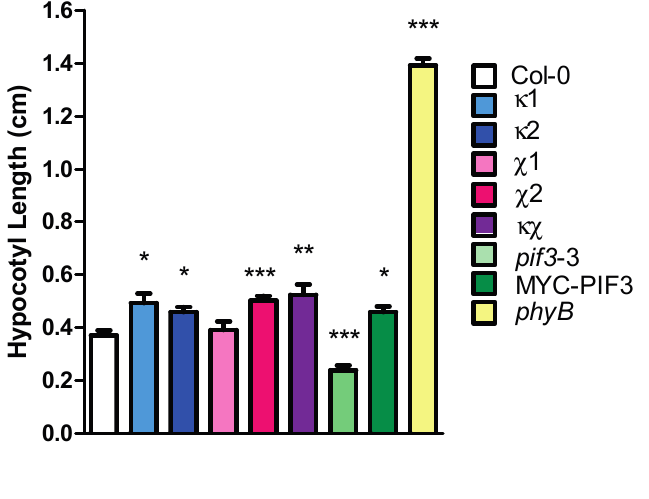
Figure 3. Hypocotyl lengths of 14-3-3 mutants grown in continuous red (cR) light. Col-0 (wild-type), κ 1 (salk_148929), κ 2 (salk_001375), χ 1 (salk_150150), χ 2 (salk_142285), κχ double-mutant (salk_001375; salk_142285), pif3 -3, MYC-PIF3 and phyB were germinated and grown in cR light for five days. Statistically significant differences compared to the wild-type are indicated with asterisks ( n > 11): * p < 0.05, ** p < 0.01, *** p < 0.001. These experiments were repeated multiple times, and representative data are